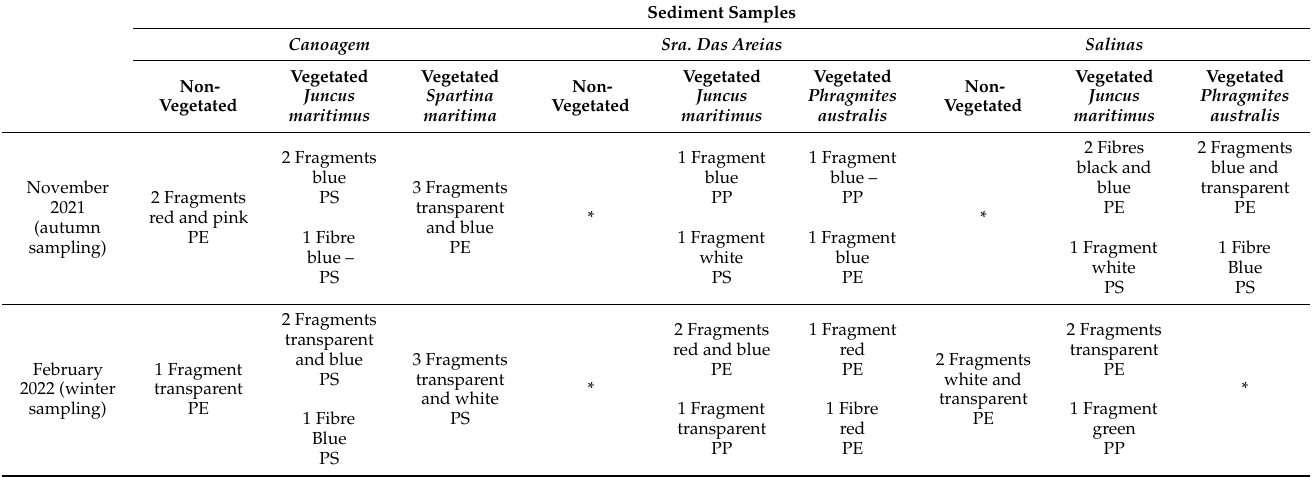
Table 1. Polymer type, polyethylene (PE), polypropylene (PP), and polystyrene (PS) of the MPs found in sediment samples (vegetated and non-vegetated) collected in autumn (November 2021) and in winter (February 2022) at the three sampling sites (Canoagem, Sra. Areias, and Salinas, locations in Figure 1). * not possible to characterise MPs polymers due to their low size and/or amount.